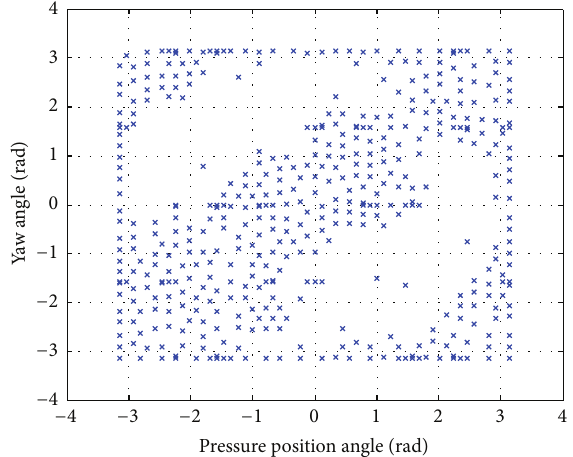
Figure 15: Training points chosen by the G-optimal design proce-